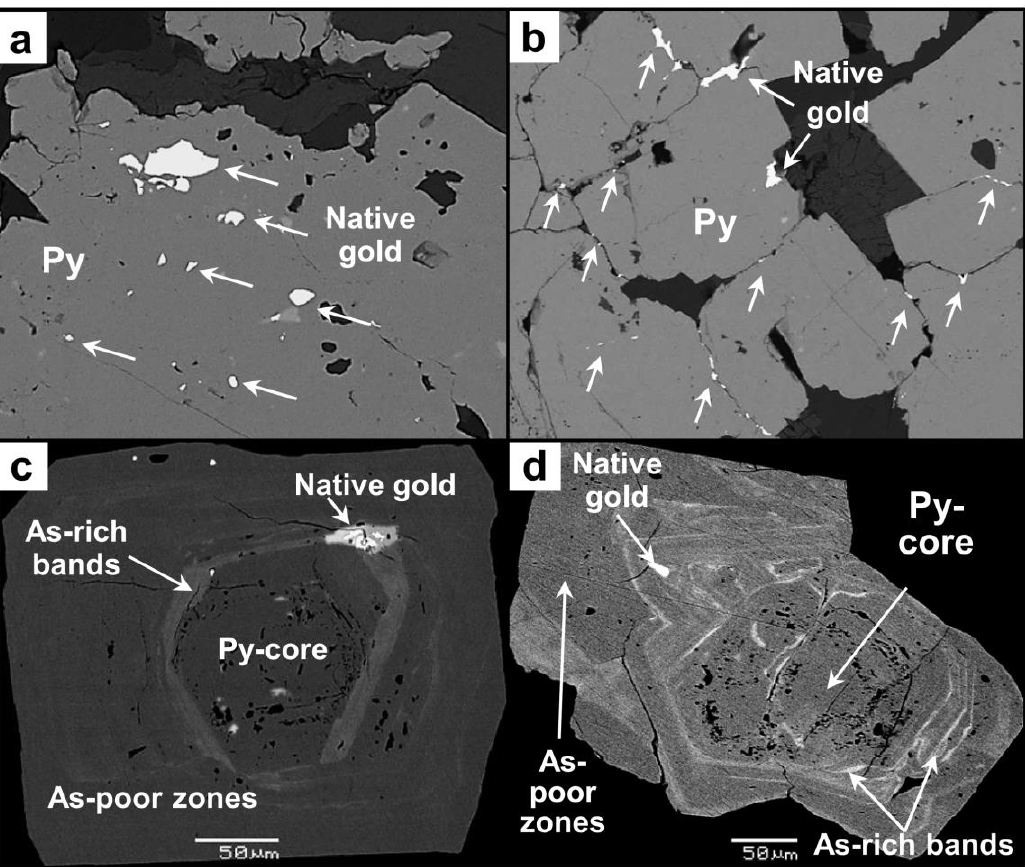
Figure 4. SEM backscattered electron images illustrating features in pyrite at El Callao. Native gold occurs as mineral inclusion ( a ) and filling fractures in pyrite ( b ). ( c , d ) Asymmetric sequential overgrowths surrounding pyrite cores, with inclusions of native gold in As-rich band.